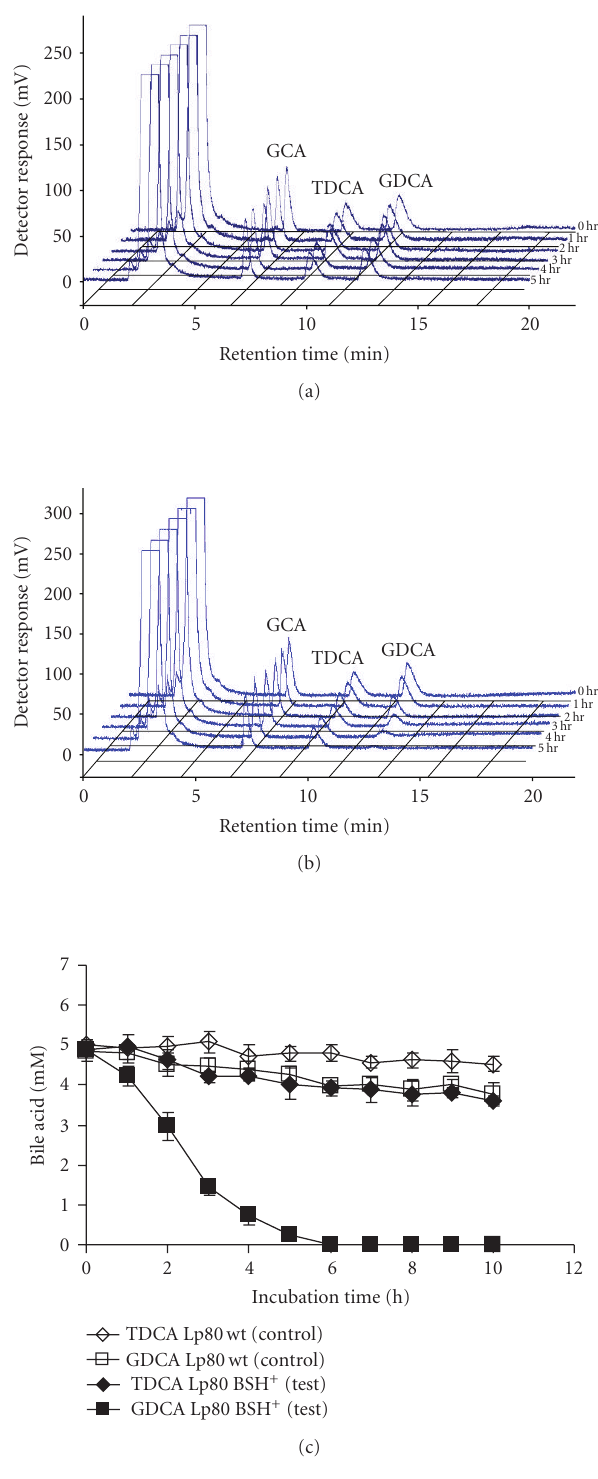
Figure 2: Bile acid deconjugation by microencapsulated L. plan- tarum 80 wild type (control) cells and microencapsulated L. plan- tarum 80 BSH + (test) cells in simulated intestine following 60- minute exposure time in simulated stomach. Overlaid HPLC chro- matograms showing decreasing TDCA and GDCA concentrations over time by microencapsulated (a) Lp80 wild type cells and (b) Lp80 BSH + cells. (c) Graphical comparison of control and test mi- crocapsules. GCA was used as internal